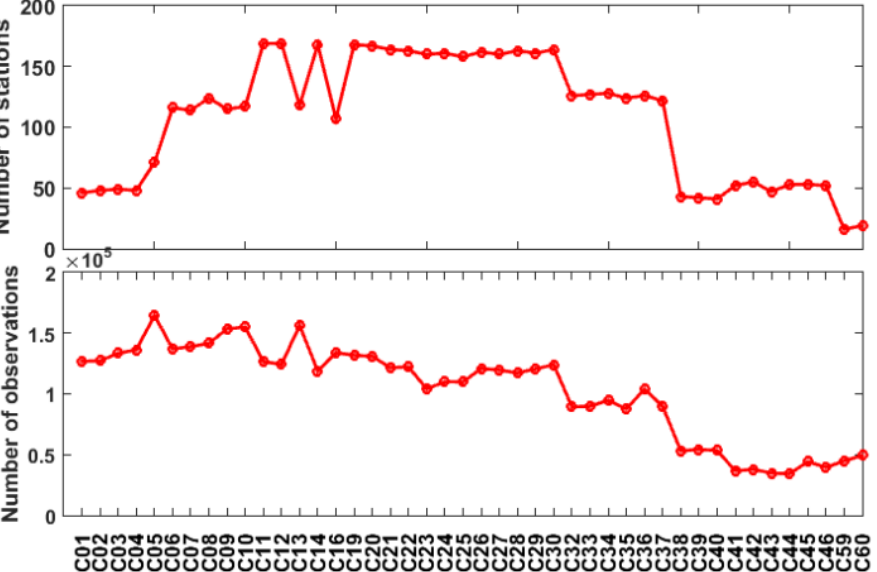
Figure 11. Numbers of tracking stations and contributed observations for each BDS satellite in the C2I-C6I DCB estimation on DOY 214, 2020.